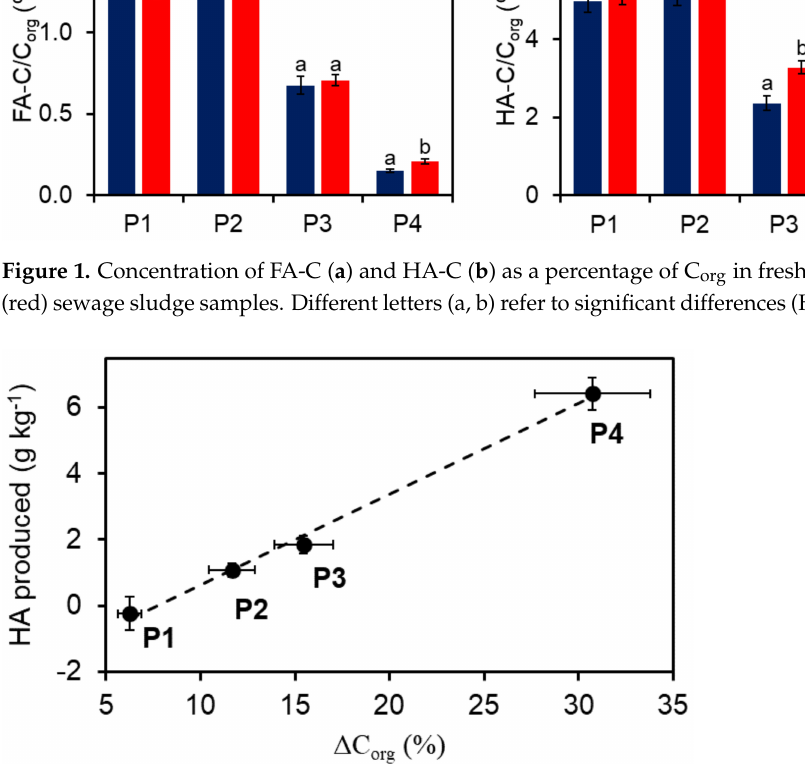
Figure 2. Amount of humic acid (HA) produced during storage as a function of the loss C org ( ∆ C org